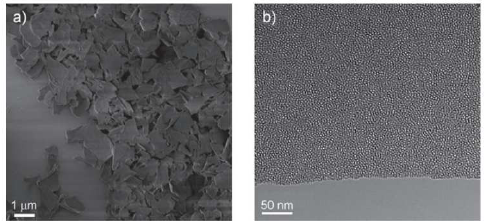
Figure 12. GN nanosheets analysis ( a ) SEM; ( b ) TEM images at different temperature. Reprinted with permission from [80]. Copyright (2010) Wiley Online